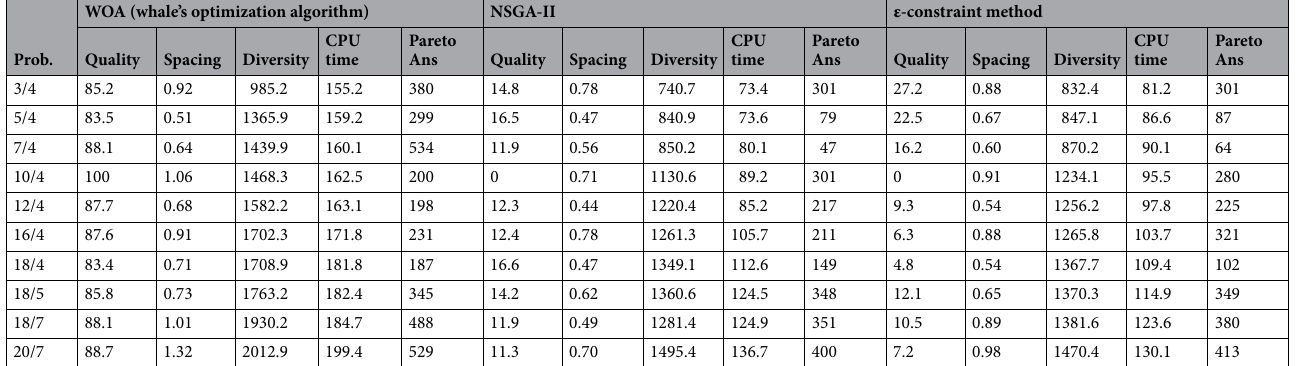
Table 9. Results for solving small size issues.